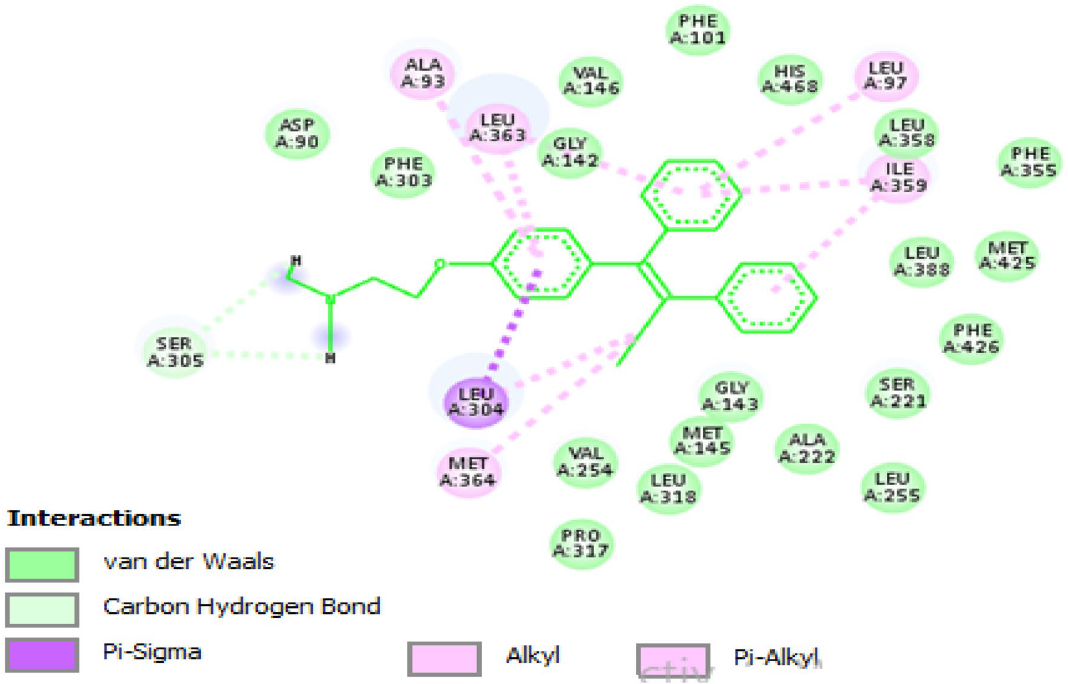
Figure 9. 2D interactions of tamoxifen with CES1 protein binding site (pdb ID: